Question: Generate an informative caption for the figure above.
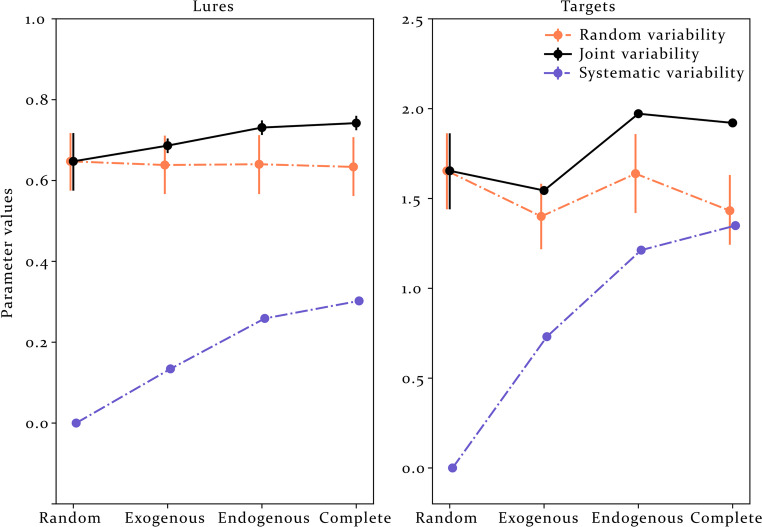
Answer: Model-estimated η parameters based on experimental data. The joint variability is calculated as square root of the sum of the random and systematic variances. The error bar represents the 95% highest posterior density interval. Random = standard DDM, Exogenous = DDM with only exogenous regressors, Endogenous = DDM with only endogenous regressors, Complete = DDM with all regressors